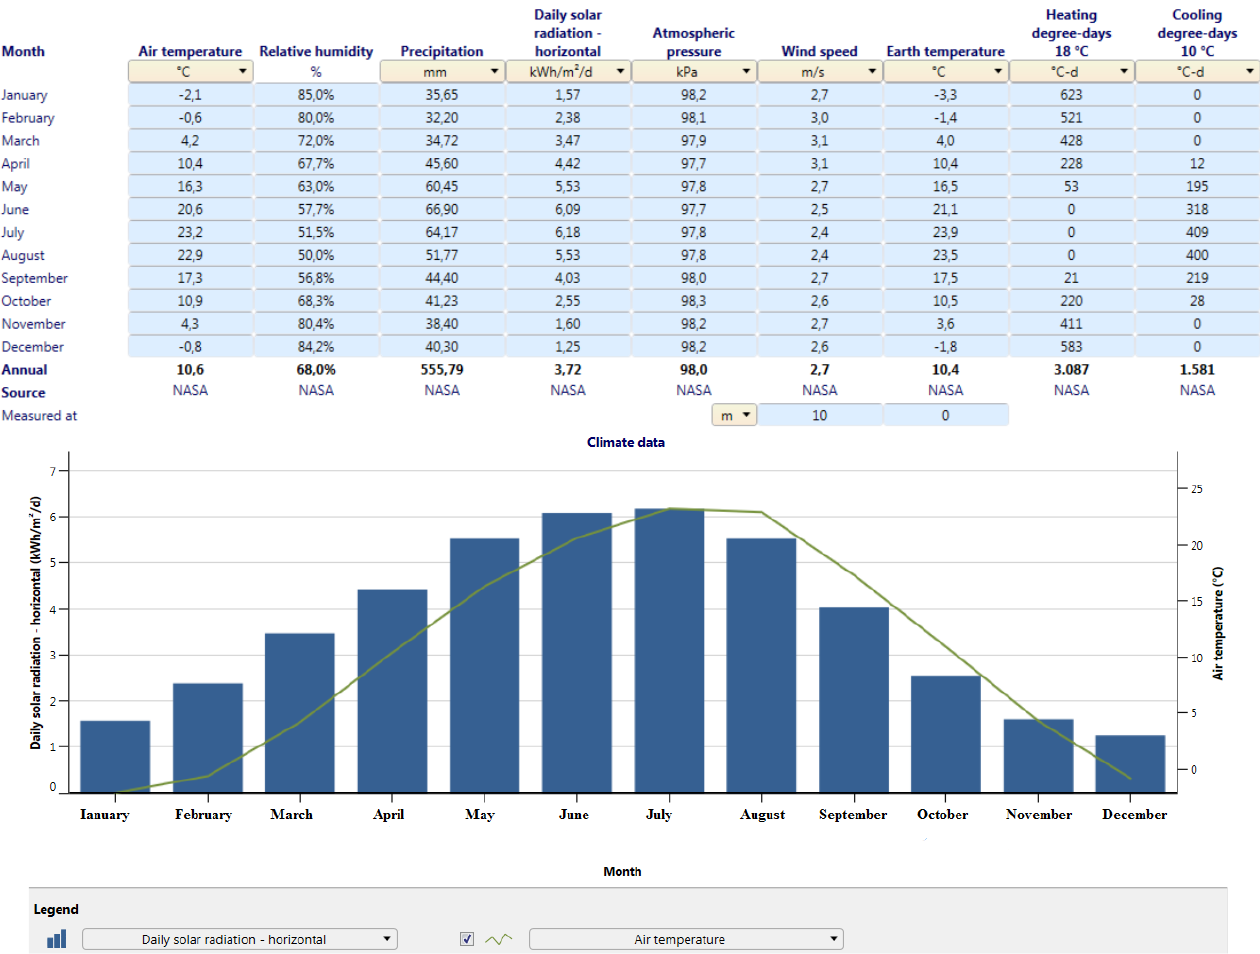
Figure 2. The values of the main parameters ( top ) and the representation per month in a year ( bottom ) for solar radiation (bar graph) and air temperature (green line).